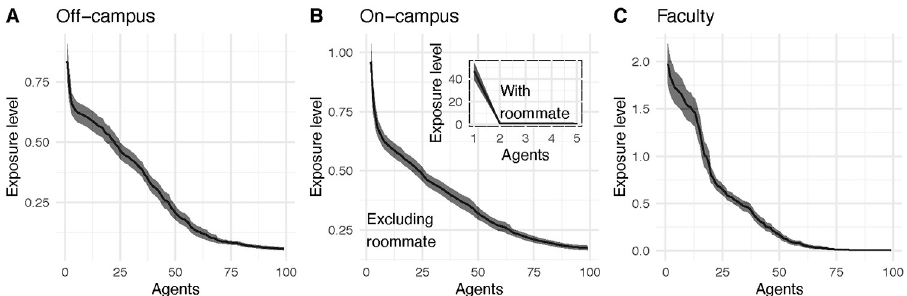
Fig 5. Exposure profiles for 100 agents are arranged in decreasing order then averaged. A 95% confidence interval is included around the curve. Panel A shows the exposure profile for off-campus students. The larger panel of Panel B shows the exposure profile for on-campus students with the maximum entry (corresponding to a dorm roommate) removed. The smaller subpanel in Panel B shows the exposure profile when the roommate is included. Panel C shows the ordered average exposure profile for 100